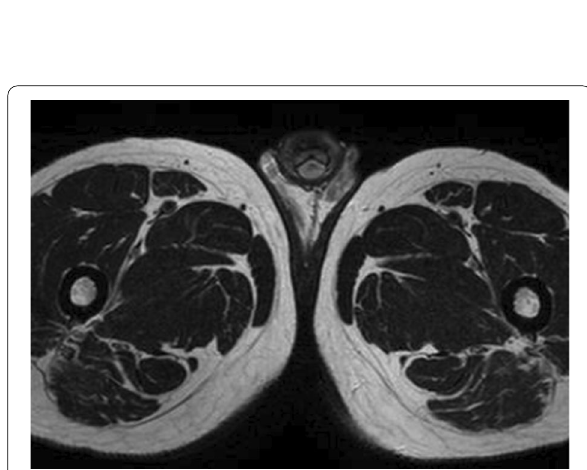
Fig. 2 MRI coronal T2 weighted image shows bilateral normal spermatic cord structures entering from the inguinal canal to the scrotum